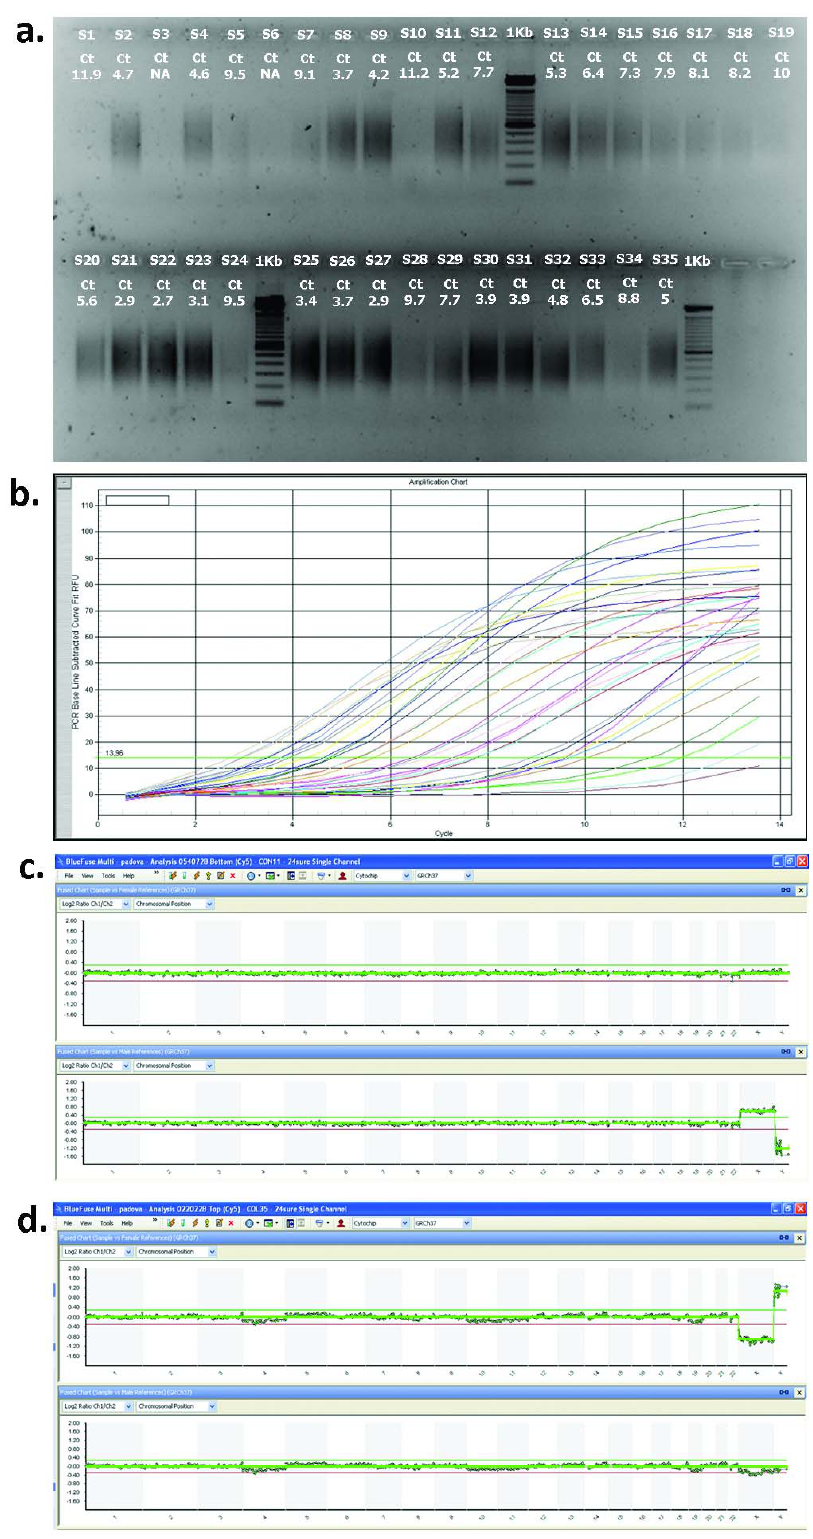
Figure 2. WGA analysis and aCGH of single sperm.a . Gel electrophoresis of WGA products from single human sperm. Ct: cycle threshold as determined by Real-Time PCR with SYBR Green. b . Real-Time PCR of the same WGA products. The difference in fluorescence (fluorescence at the end of each cycle minus baseline fluorescence level) is plotted against the cycle number. Hybridization failed for samples with a cycle threshold . 10. c . Molecular karyotype of a normal 23,X sperm co-hybridized with female (upper panel) and male reference (lower panel). d . Molecular karyotype of a normal 23,Y sperm co-hybridized with a female (upper panel) and a male reference (lower panel).